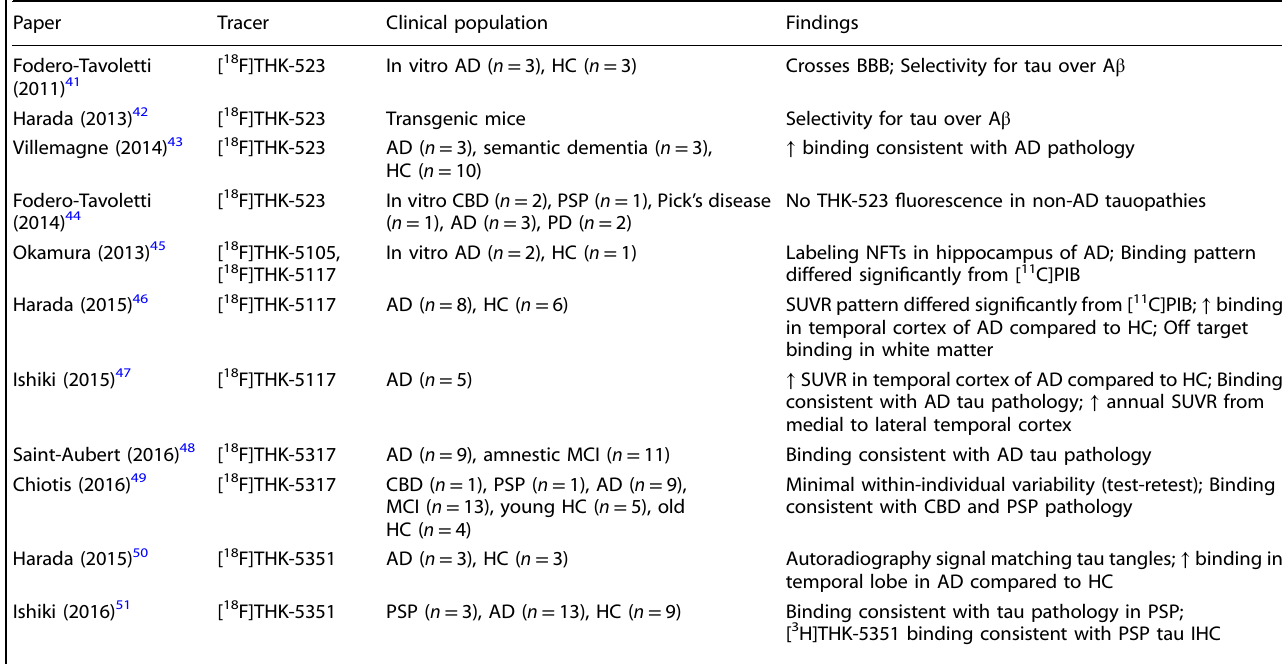
Table 3. Main fi ndings from PET studies tau using THK derivatives Paper